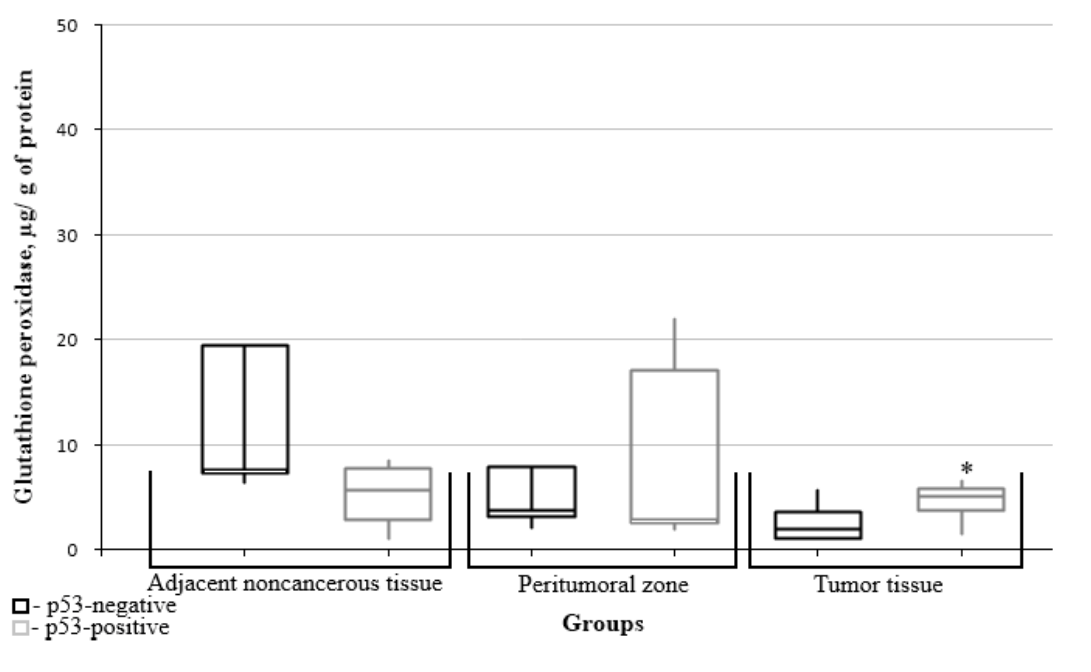
Figure 9. Medians and interquartile ranges (IQRs) of glutathione peroxidase levels in gliomal tissues as a function of the p53 protein tumor suppressor expression. There are significant differences of tumor glutathione peroxidase levels between the groups with/without expression of the p53 protein tumor suppressor (*—Mann-Whitney U-test p = 0.043). The glutathione reductase content in noncancerous tissues adjacent to the tumors was significantly lower in the p53 group (Figure 10).